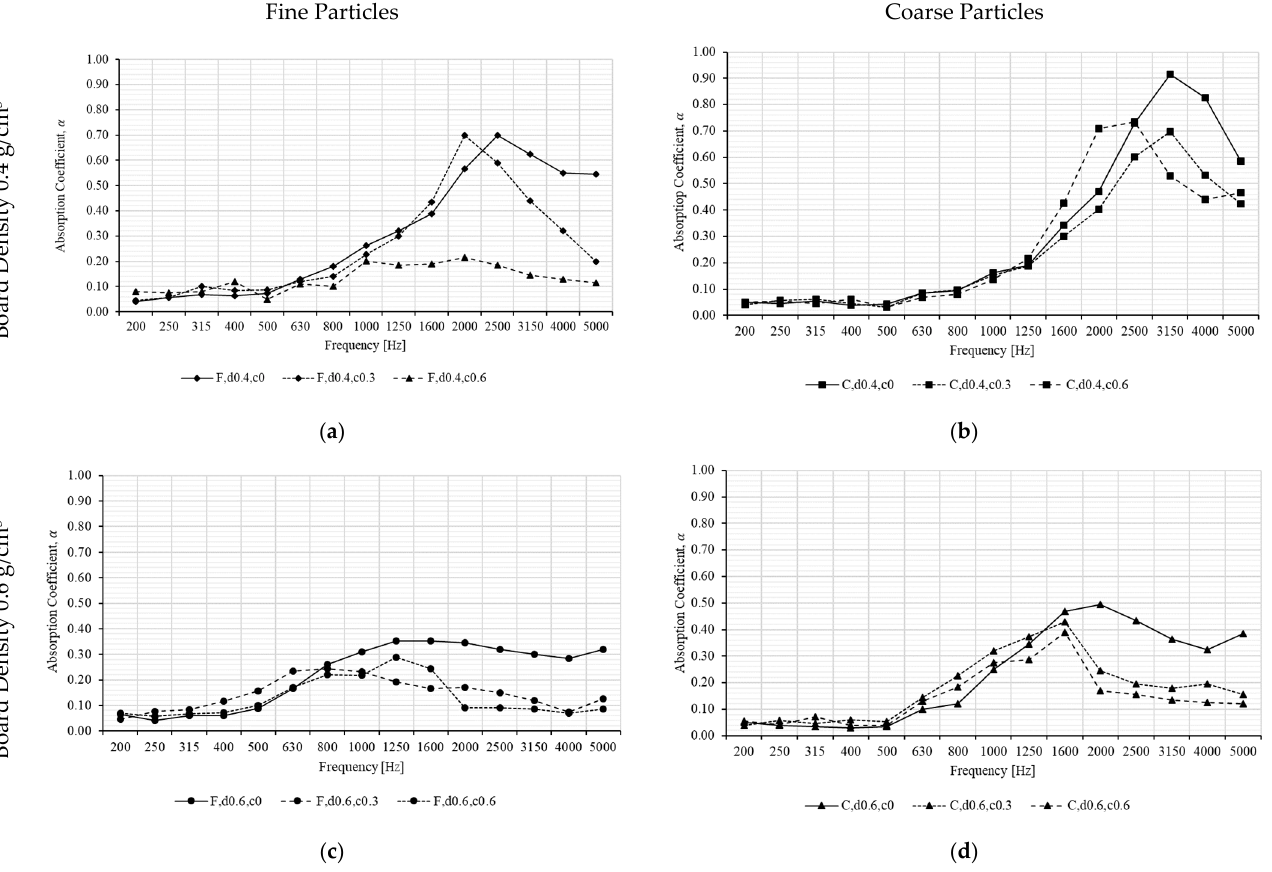
Figure 10. Sound absorption coefficient, 𝛼, particle board of various PU coating thickness with difference in particle size and board density at various frequencies: particle board using fine ( a ) and coarse particles ( b ) with board density 0.4 g/cm 3 ; and particle board using fine ( c ) and coarse particles ( d ) with board density 0.6 g/cm 3 .